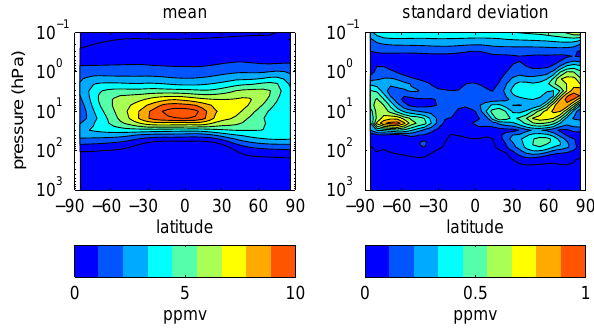
Fig. 5. CMAM March O 3 : (left) monthly mean zonal mean O 3 and (right) monthly zonal standard deviation O 3 as function of latitude and